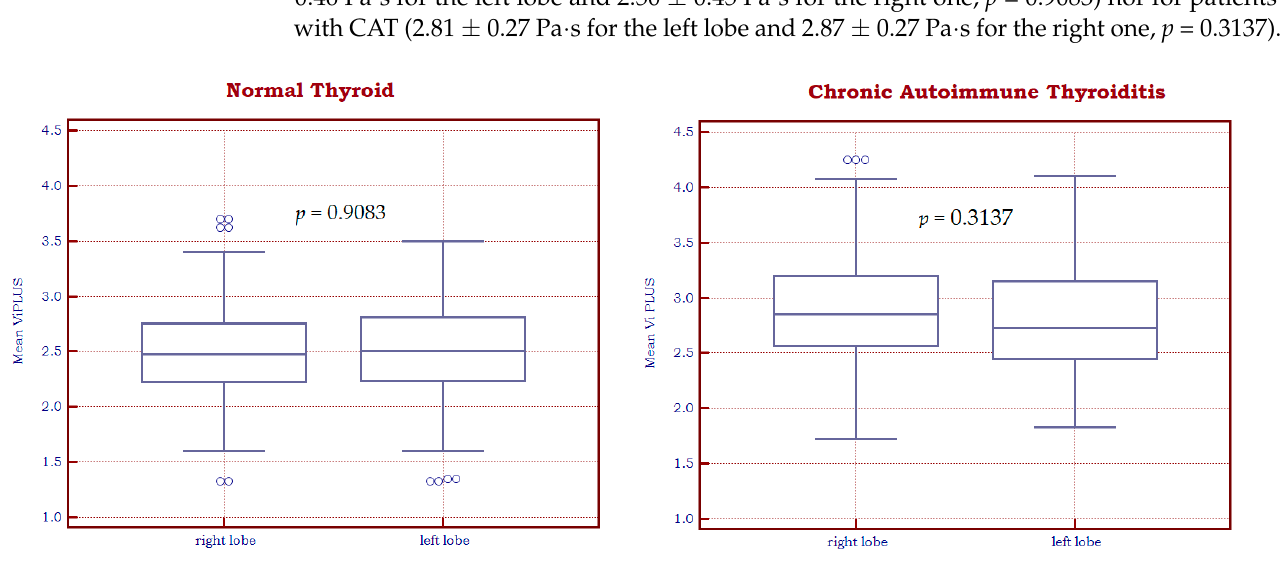
Figure 5. Box-and-whisker distribution plots representing Vi PLUS values in patients with autoim- mune thyroiditis versus patients with a healthy thyroid.